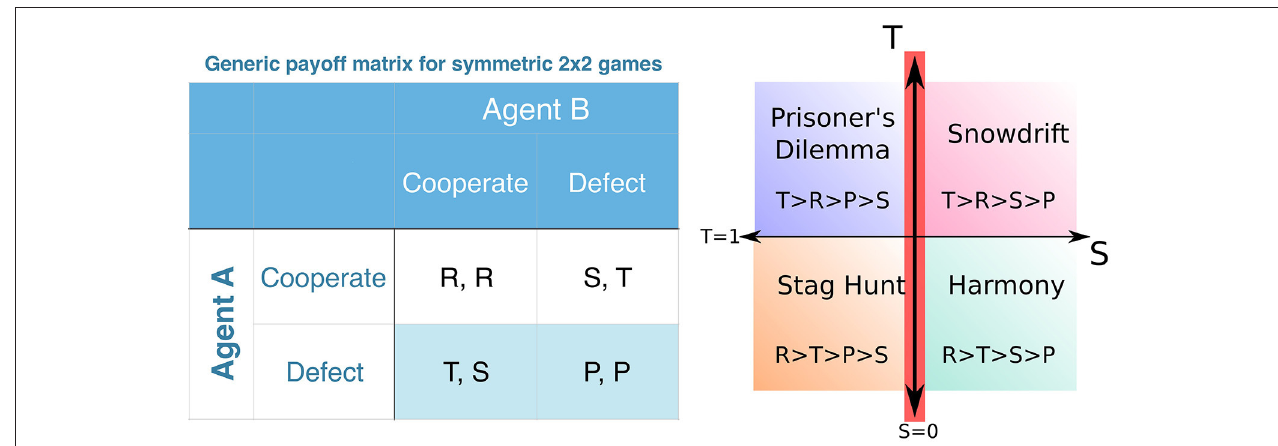
FIGURE 1 | (Left) Generic payoff matrix for symmetric two-player games. The first and second entries of each payoff pair for each of the four possible outcomes refer to the payoffs assigned to agents A and B, respectively. (Right) Schematic illustrating the different types of symmetric 2 range that we consider (adapted from [14]). Depending on the relative ordering of the payoffs the nature of the game changes between Prisoner’s Dilemma (PD: T > R > P > S ), Snowdrift (SD: T > R > S > P ), Stag Hunt (SH: R > T > P > S ) and Harmony (HA: R > T > S > P ). Note that as R > P for all of these games, we can set R 1 and P 0 which fixes the scale and origin, respectively, of the units in which payoff values are measured. Thus, without any loss of generality, we = = T plane in the figure. For the results presented here, we focus on the case S visualize the games on the S − T -axis, highlighted in